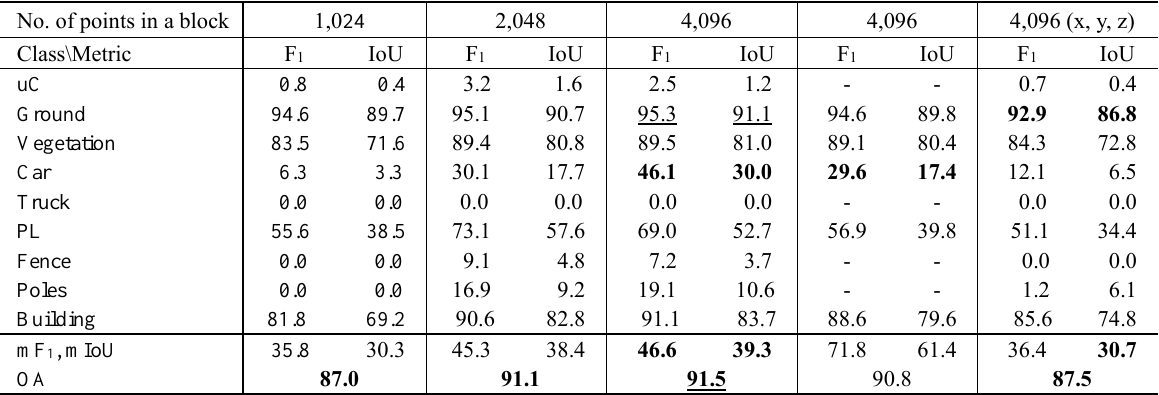
Table 2. PointNet performance metrics for the DALES test dataset (values are in %), ‘-’ indicates no available results for the class, because the class was not considered for the analysis.